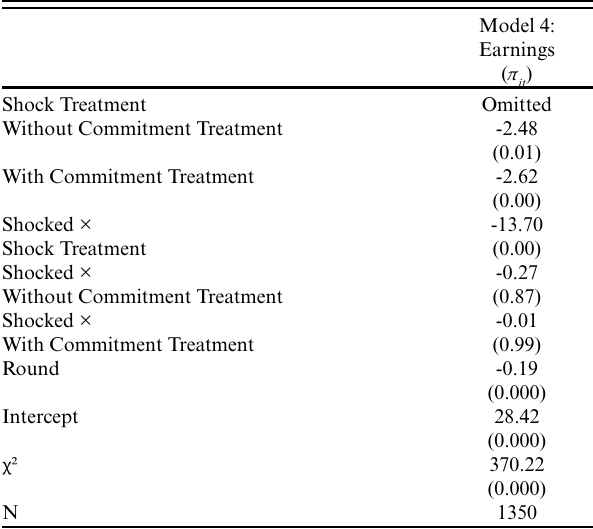
Table 5 . Conditional estimates of individual earnings.